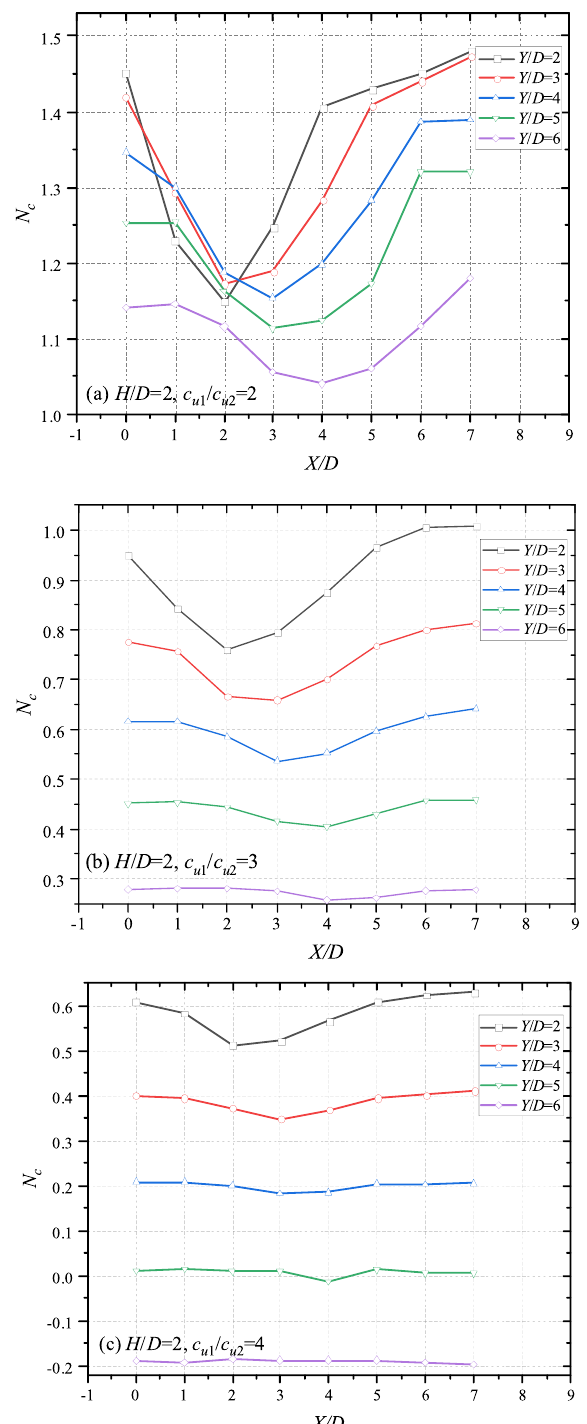
Figure 7. Variation of N c with different X / D and Y / D for ( a ) H / D = 2, c u1 / c u2 = 2; ( b ) H / D = 2, c u1 / c u2 = 3 and ( c ) H / D = 2, c u1 / c u2 =